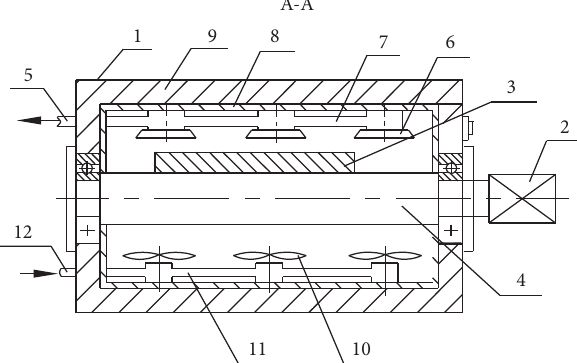
Figure 3: Section view of A-A in the structure of the hot air edge temperature compensation roller incubator for rolling the magnesium alloy.1, roller incubator; 2, roller motor; 3, magnesium plate; 4, transmission roller; 5, heat recycling pipe; 6, heat recovery unit; 7, heat return pipe; 8, insulation layer; 9, insulation box shell; 10, air uniform diffuser; 11, heat transfer branch pipe; 12, hot air pipeline.